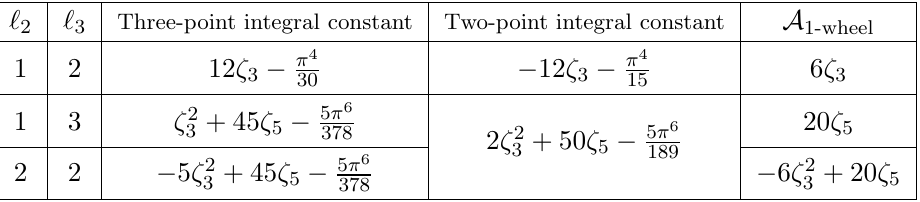
Table 2 . Terms (cid:15) 0 for the dimensionally regularised three- and two-point integrals in eq. (3.43), (cid:24) with the spacetime dependence stripped o(cid:11). The integrals were computed using the G -scheme normalization [71]. The last column gives the normalised structure constants, in perfect agreement with the integrability predictions in table 1.